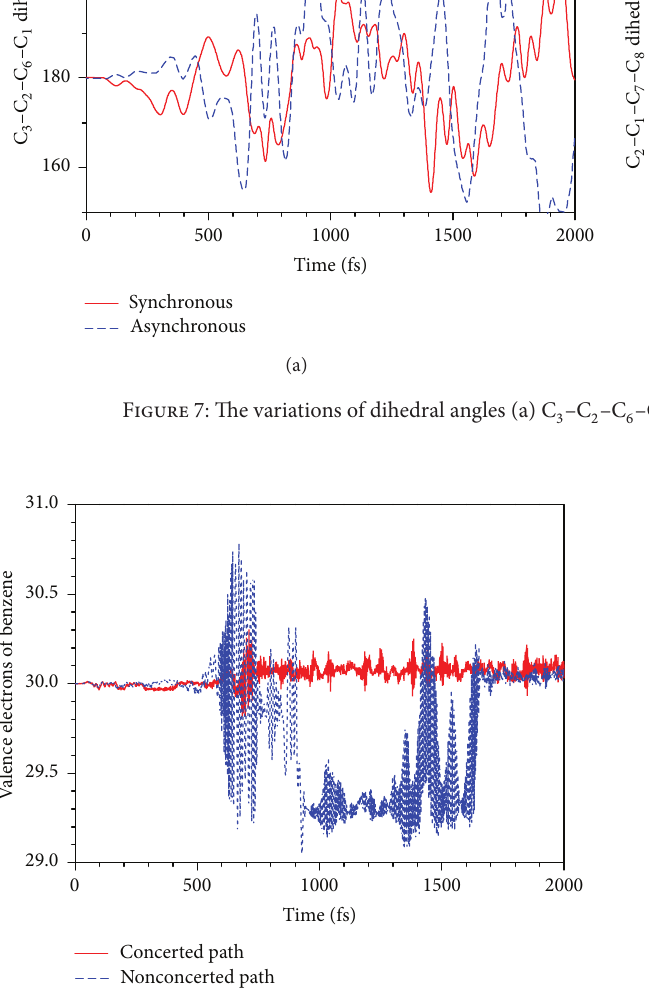
Figure9:ComparisonofHOMOandLUMOenergygapandC 2 –C 8 distance for asynchronous